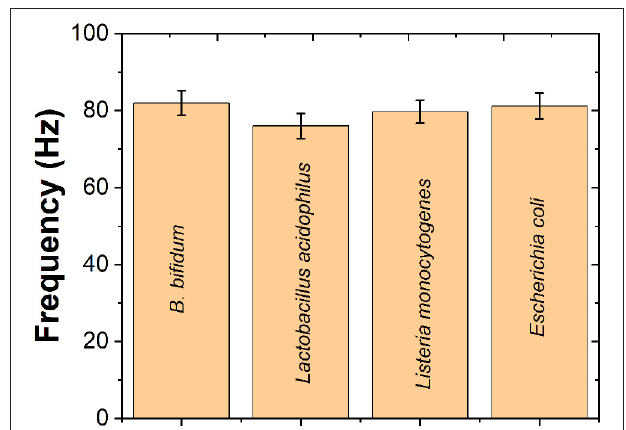
FIGURE 6 | Selectivity performance of the proposed QCM immunosensor toward B. bifidum sensing compared with that of the Lactobacillus acidophilus , Listeria monocytogenes and Escherichia coli .